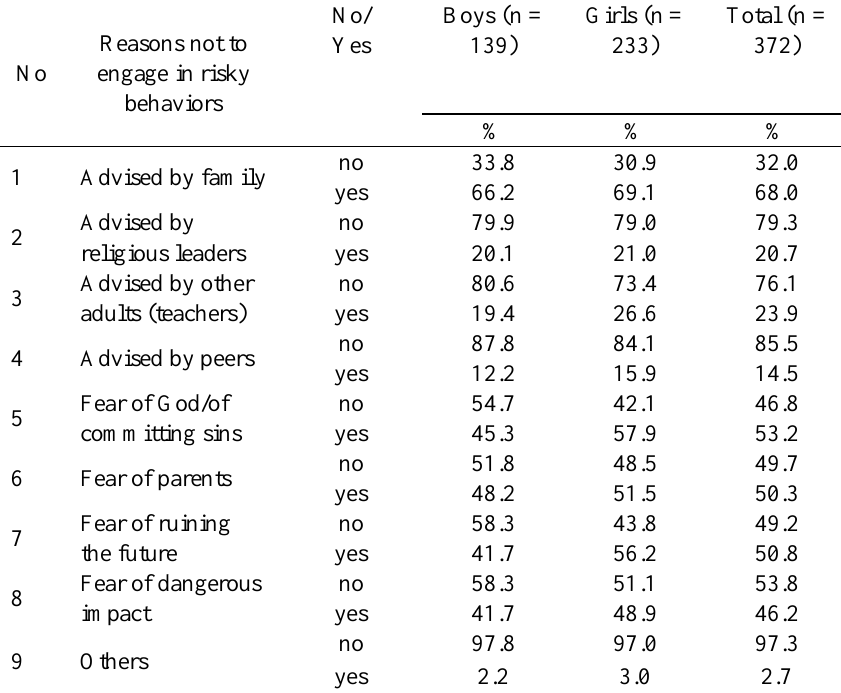
Reasons Not to Engage in Risky